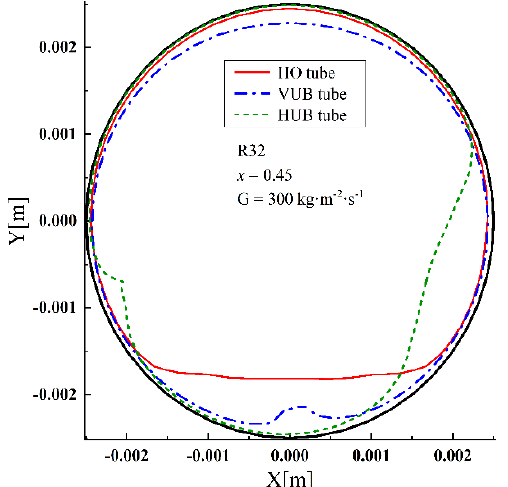
Figure 11. Vapor – liquid interface of R32 at different tubes.